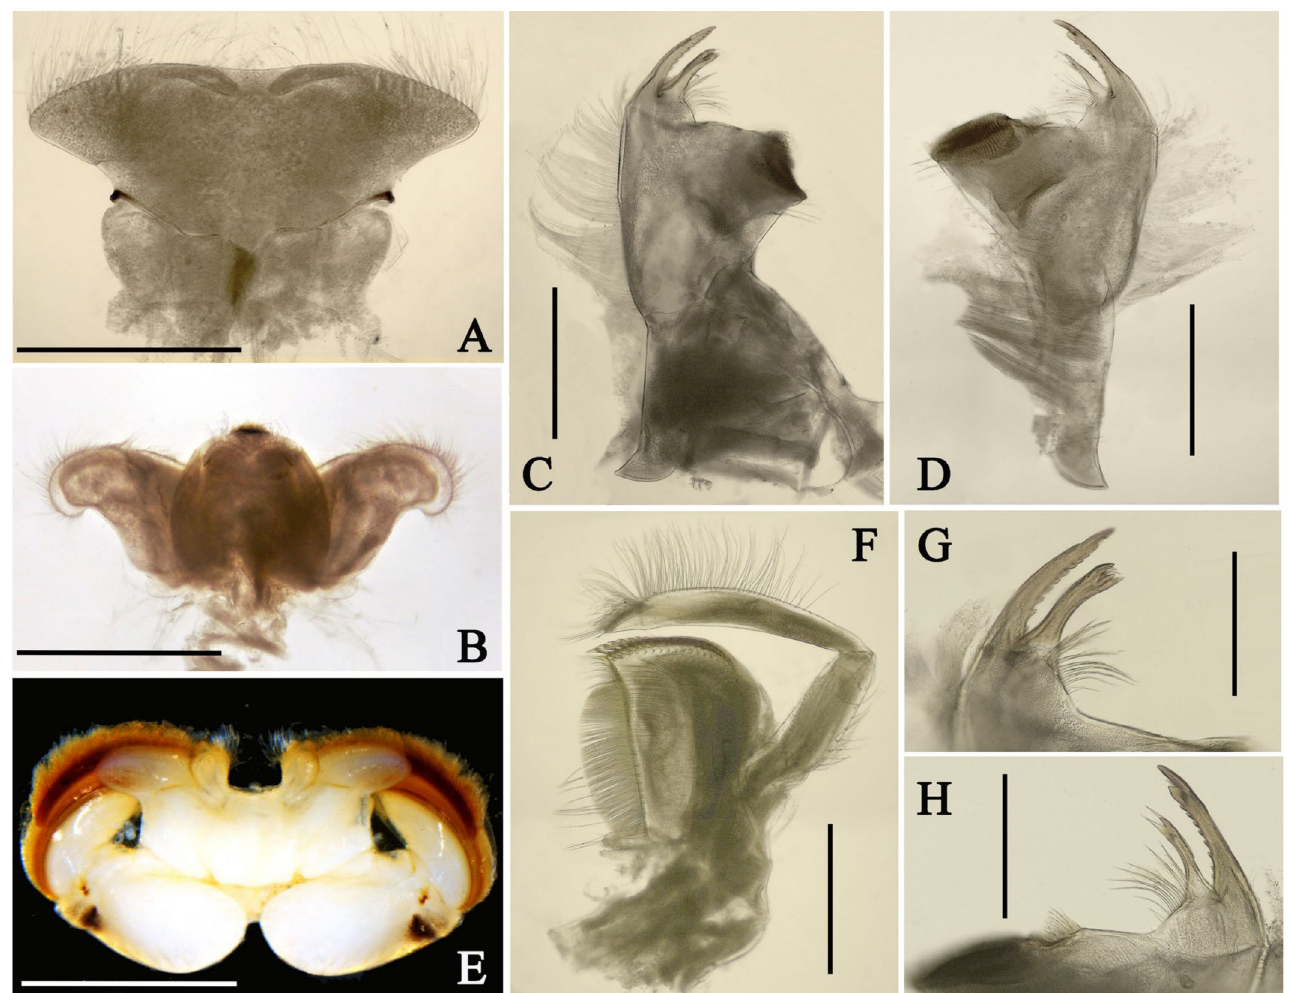
Figure 2. Mouthparts of Maculogenia ngi (digital photos): ( A ) labrum (ventral view); ( B ) hypopharynx (ventral view); ( C ) left mandible; ( D ) right mandible; ( E ) labium (ventral view); ( F ) maxillae; ( G ) in- cisors of left mandible; ( H ) incisors of right mandible. Scale bars: ( A – E ) = 0.5 mm; ( G , H ) = 0.2 mm.